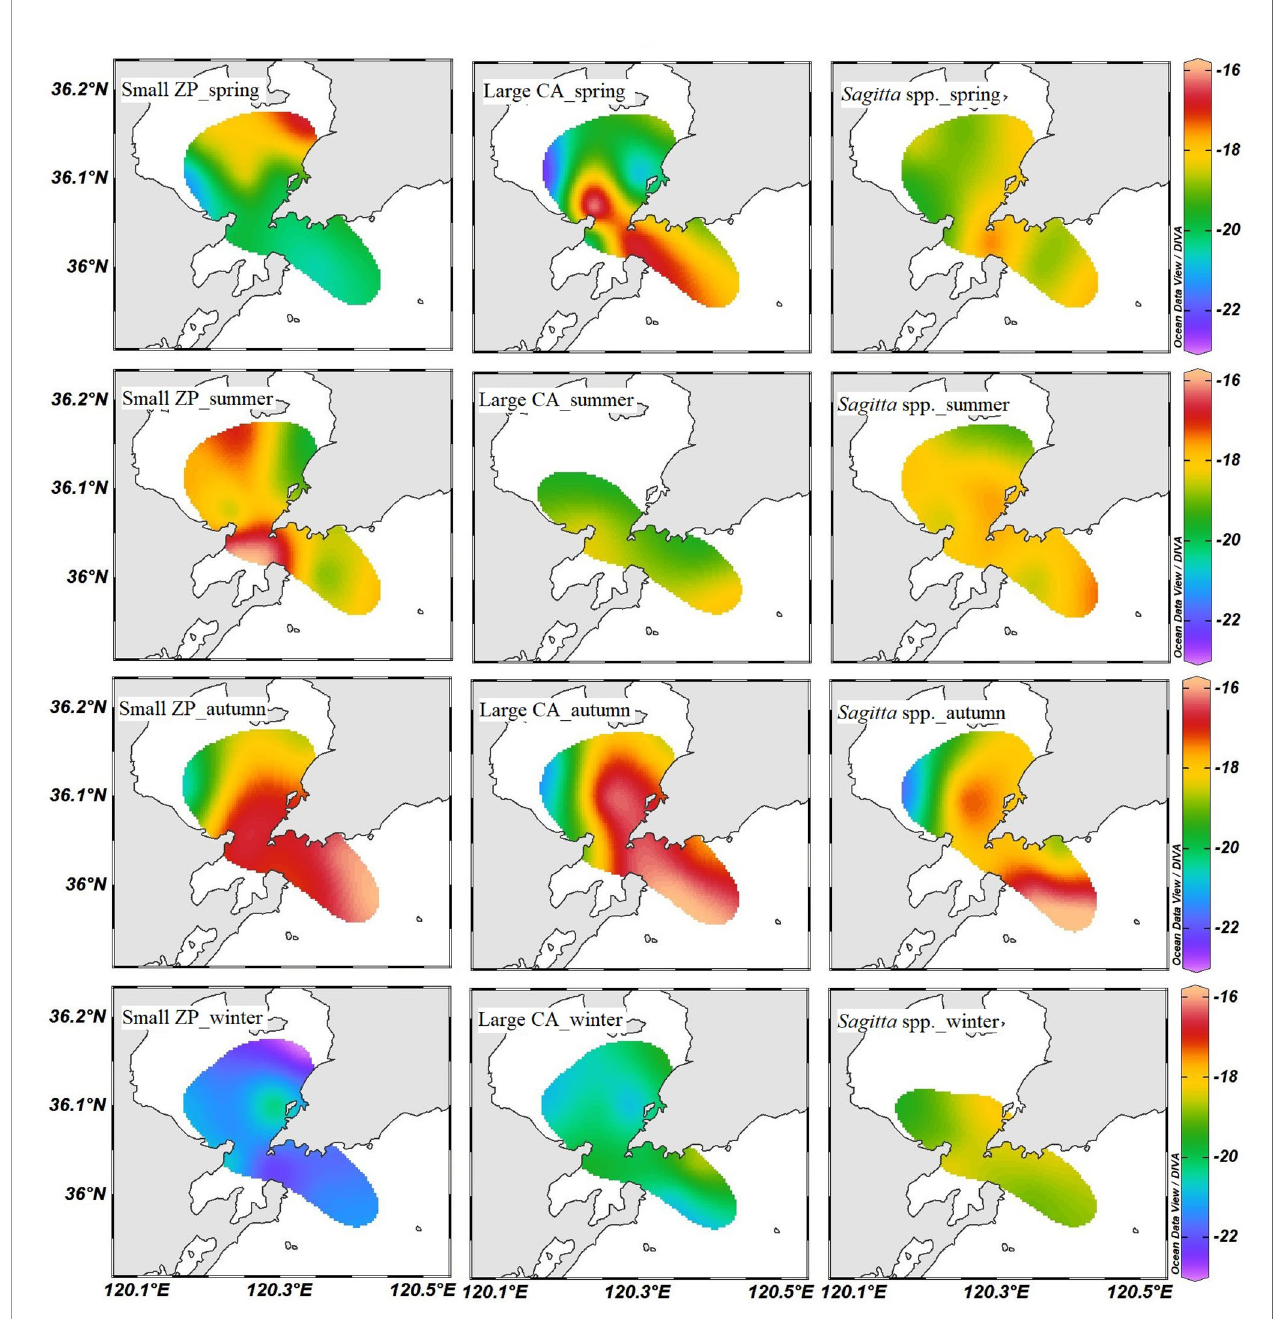
FIGURE 3 | Horizontal distribution of d 13 C in small zooplankton (small ZP), large calanoids (large CA), and Sagitta spp. in Jiaozhou